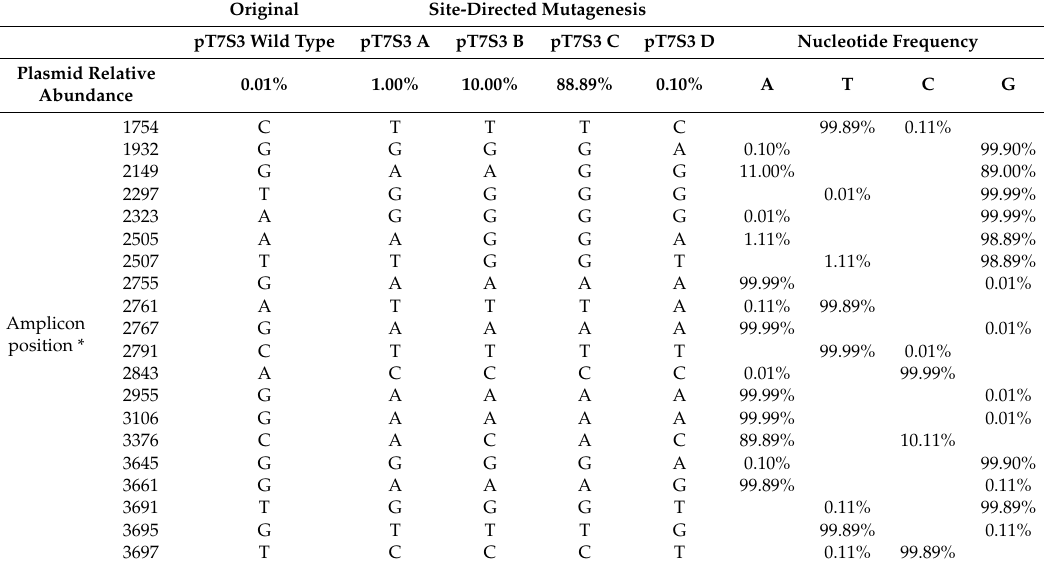
Table 1. The location of the site-directed mutations introduced in plasmids pT7S3 A–D compared with the original pT7S3 wild type. The relative abundance of each used to create the artificial populations is provided along with the resulting single-nucleotide variant (SNV) percentage frequency *. Amplicon position is defined as the number of bases along the polymerase chain reaction (PCR) amplicon. Original Site-Directed